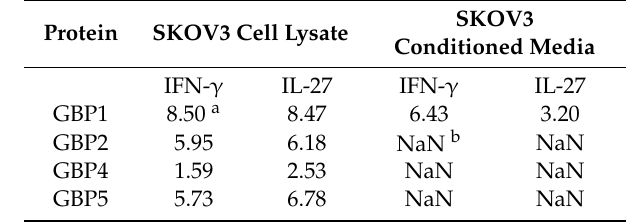
Table 1. Comparison between the t-test significant fold increase in secretome and proteome of the cell lysate.